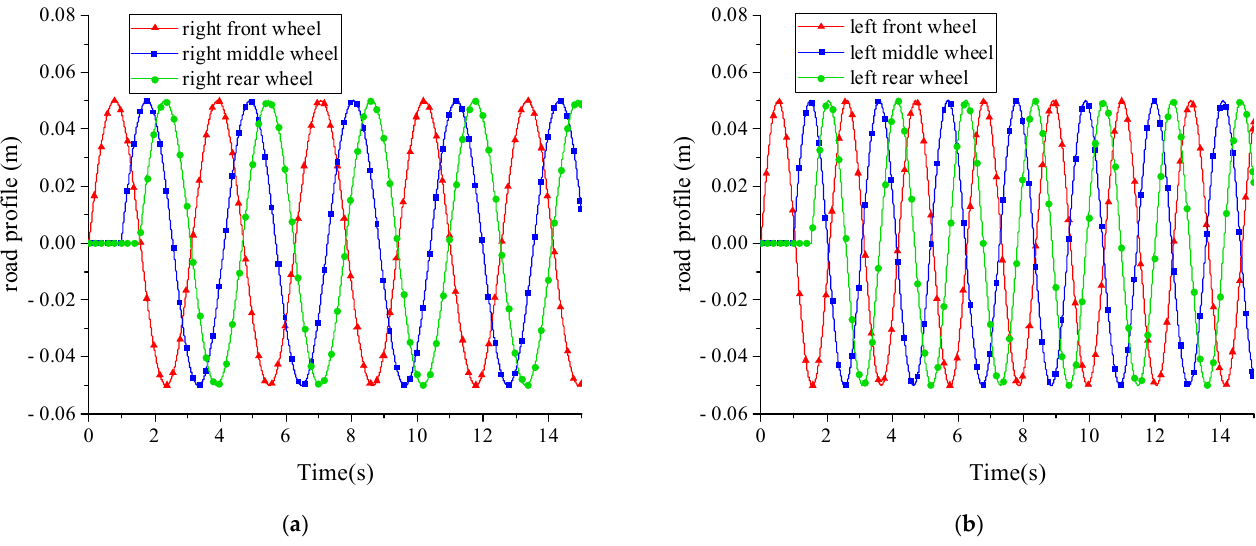
Figure 7. ( a ) Road profile of left side under sinusoidal signals; ( b ) road profile of right side under sinusoidal signals.